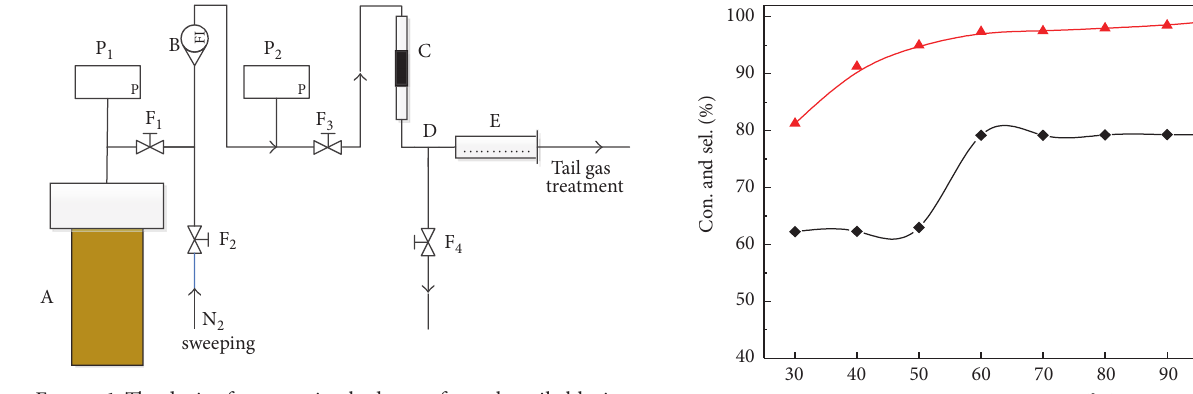
Figure 1: The device for removing hydrogen from the tail chlorine. (A) Gas tank, (B) rotor flowmeter, (C) fixed-bed reactor, (D) sampling device, and (E) water adsorption device. F 1 , F 2 , F 3 , and F 4 represent valves, and P 1 and P 2 represent vacuum gauges.